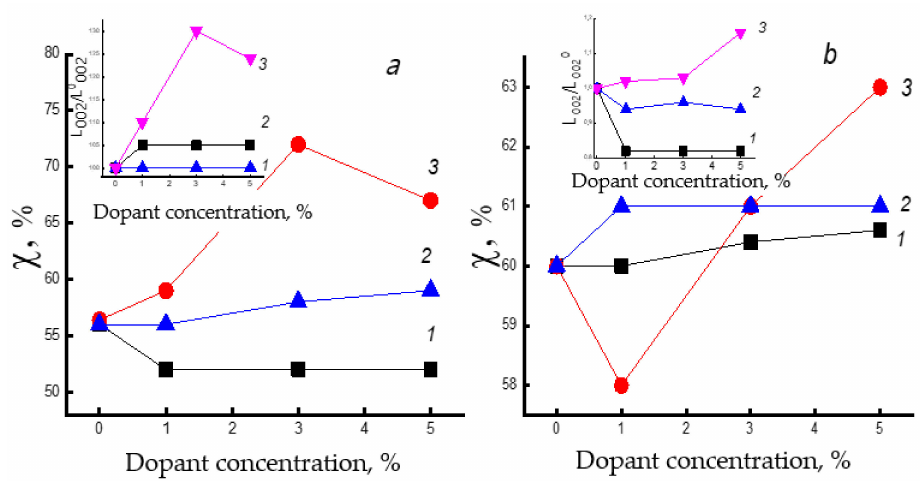
Figure 4. Crystallinity degree ( χ ) dependence and relative longitudinal size (L 00 2/L 0 00 ) evolution (the inserts) as functions of the dopant concentration. ( a ) initial fibers, ( b ) the same fibrous samples after annealing at 140 ◦ C. 1—TPP, 2—SnCl 2 -TPP,